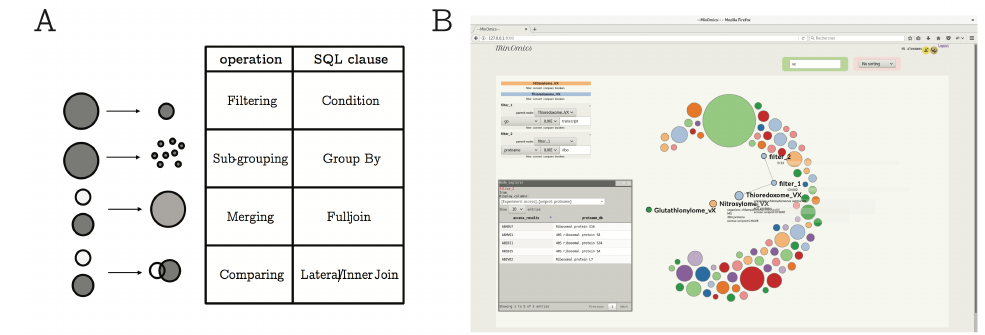
Figure 5: MinOmics query builder and web visualization. Structured query language offers relevant clauses to explore bi- ological datasets as summarized in panel (A). Diving into subsets of big data is performed through interactive web tools that control the relations and constraints of the query builder depicted in panel